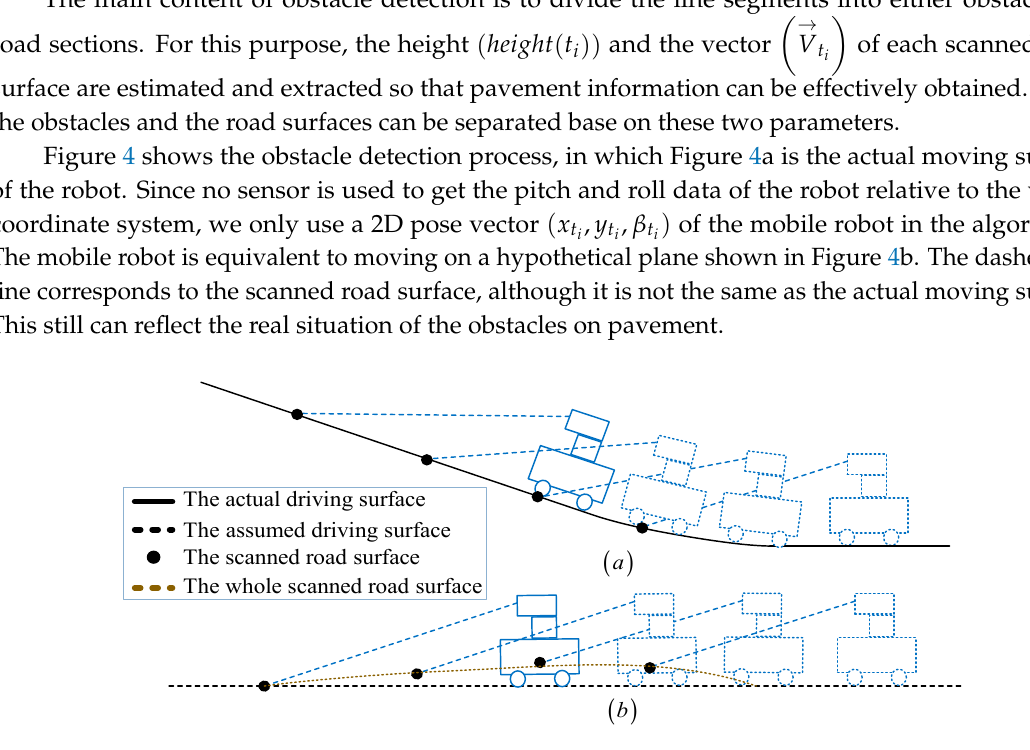
Figure 4. Obstacle detection process. ( a ) The actual moving surface; ( b ) The assumed moving surface.